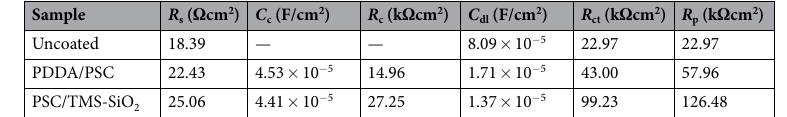
Table 3. Electrochemical parameters of uncoated and coated 316SS in 3.5% NaCl